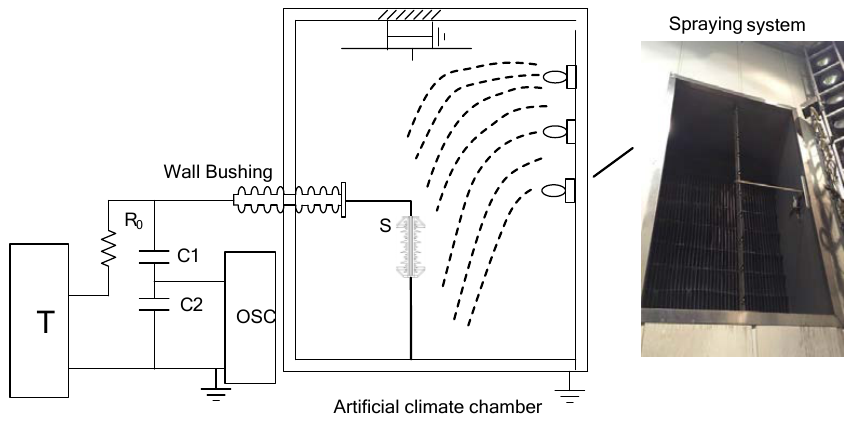
Figure 1. Experimental setup for rain flashover tests.